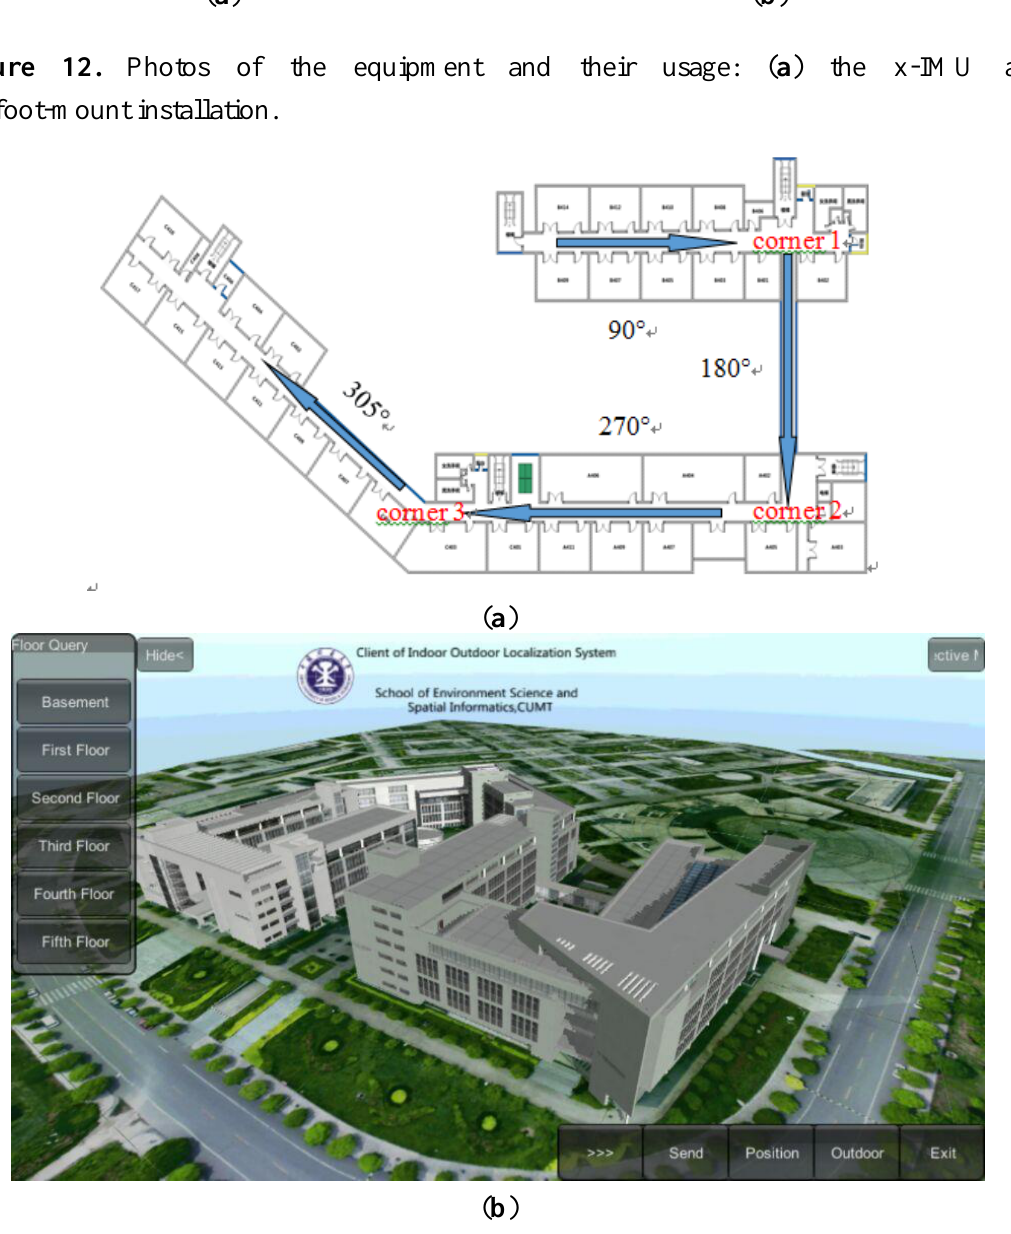
Figure 13. Experimental site: ( a ) floor map of the fourth floor and ( b ) 3D model of the experimental